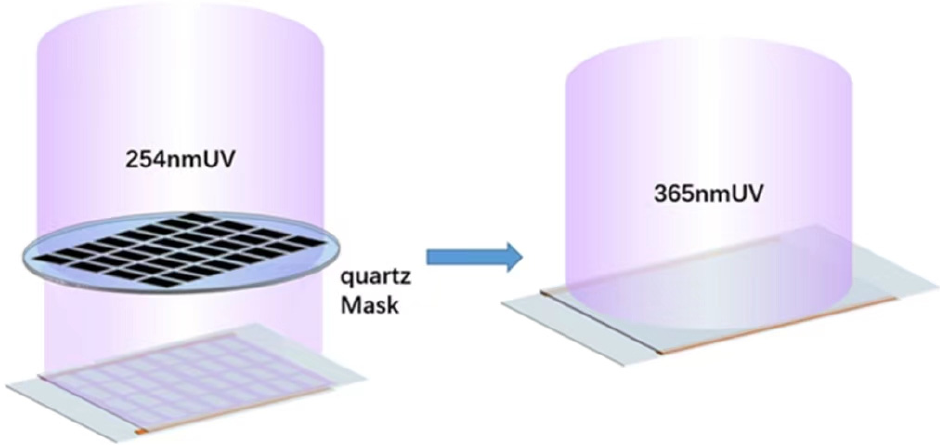
Figure 2. Schematic diagram of the step-by-step photocuring preparation of PD&SLC. Table 1. Compositions of the samples studied.